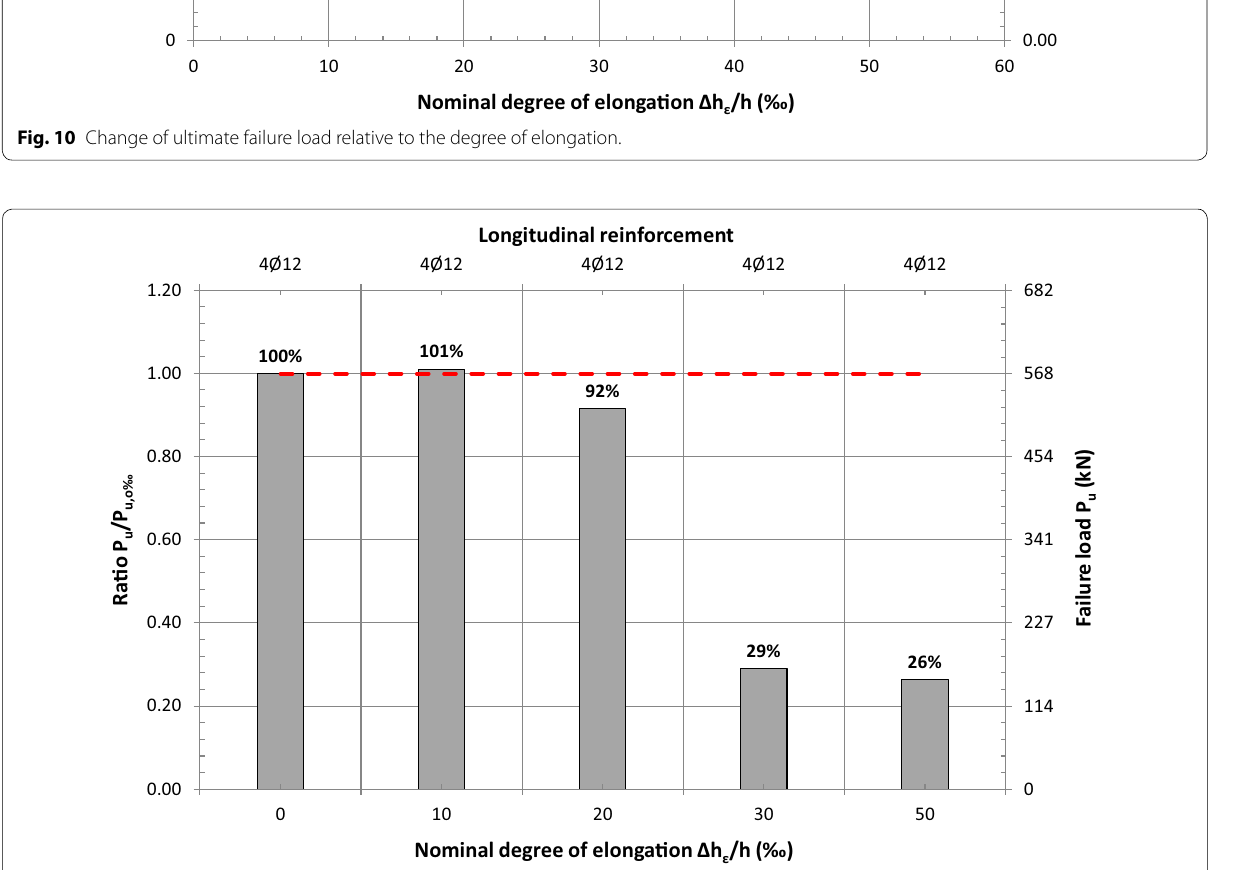
of the load of failure of the “initial” specimen. That means that tensile degree of 10‰ influences almost none the critical failure load of specimen. The small